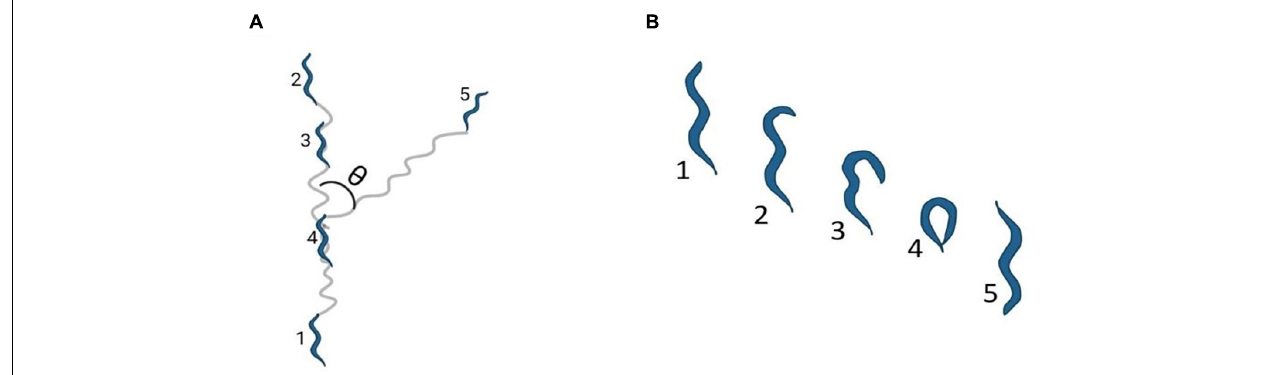
FIGURE 1 | Locomotion Pattern of C elegans . (A) Shows reversals, where θ represents the bending angle during reorientation and the numbers 1–5 indicate the stages of reversals in order (B) indicates an (cid:127) turn where the numbers 1–5 indicates the stages leading to an (cid:127) turn in order. The images have been adapted from Gray et al. (2005).